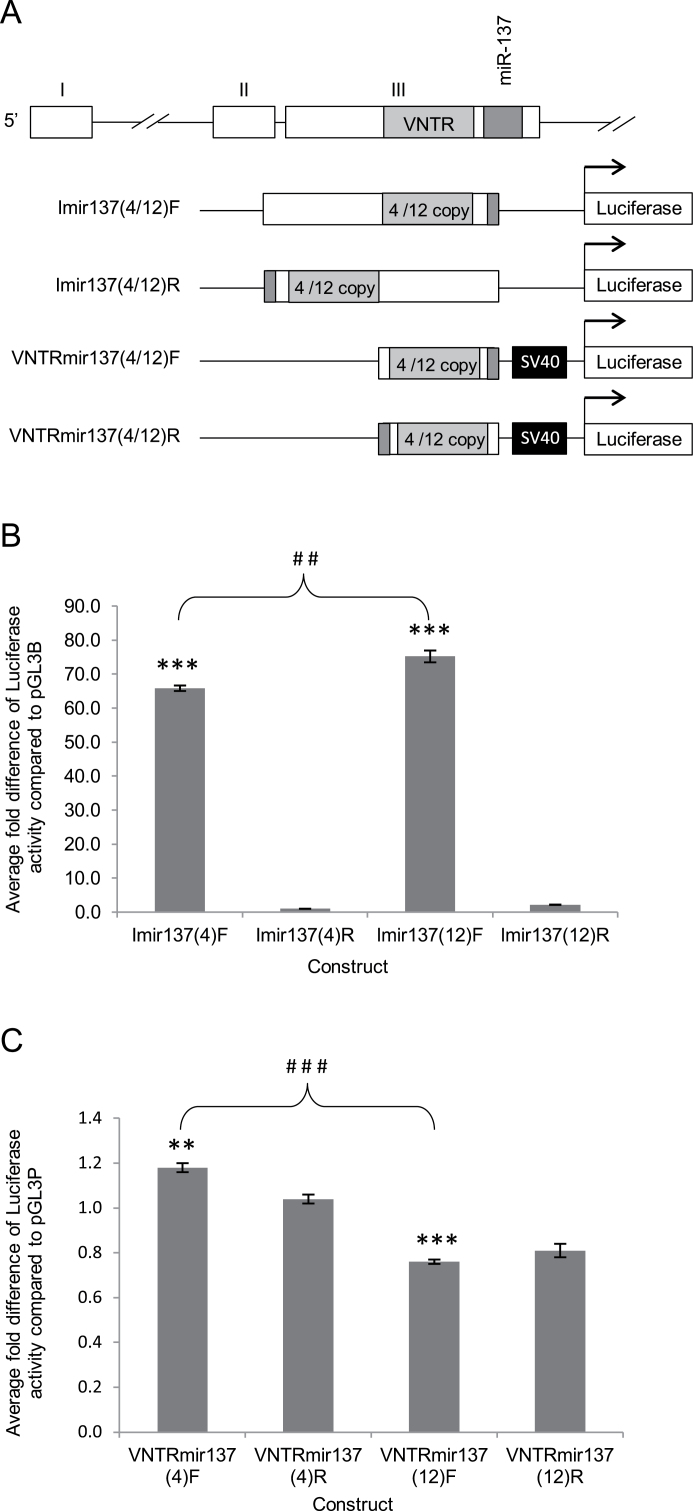
Validation of an internal promoter in the MIR137 gene. (A) Schematic representation of MIR137 constructs aligned to the MIR137 gene showing the 4-copy (Imir137(4)) and 12-copy (Imir137(12)) variants of the MIR137 VNTR ± the proximal flank region in the pGL3B (Basic) and pGL3P (Promoter) vectors, respectively, in forwards (F) and reverse (R) orientation. (B,C) Average fold change in luciferase activity supported by the MIR137 constructs over vector controls in SH-SY5Y cells. N = 4. *Significant changes in luciferase activity over backbone control. #Significant changes in luciferase activity between experimental conditions. */#
P < .05, **/##
P < .01, ***/###
P < .001.